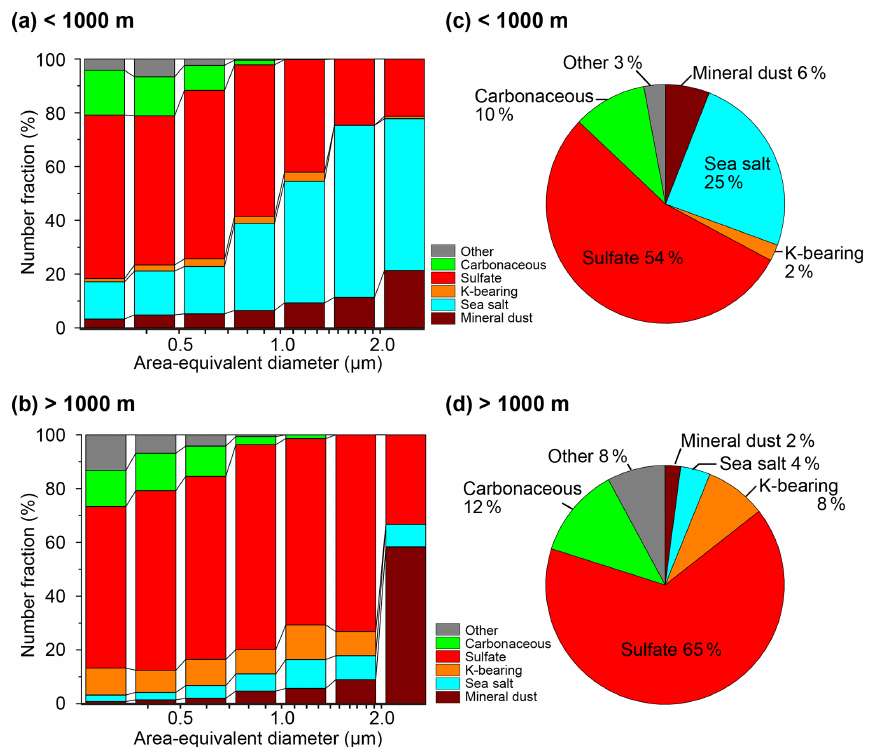
Figure 3. Size-dependent number fractions in the samples (a) < 1000m and (b) > 1000m and number fractions of the total particles of the samples (c) < 1000m and (d) > 1000m. The size bins in panels (a) and (b) are shown on a log scale and are < 0.35, 0.35–0.5, 0.5–0.71, 0.71–1.00, 1.00–1.41, 1.41–2.00, and > 2.00µm. The particle numbers used in panels (c) and (d) are 4400 and 3444,